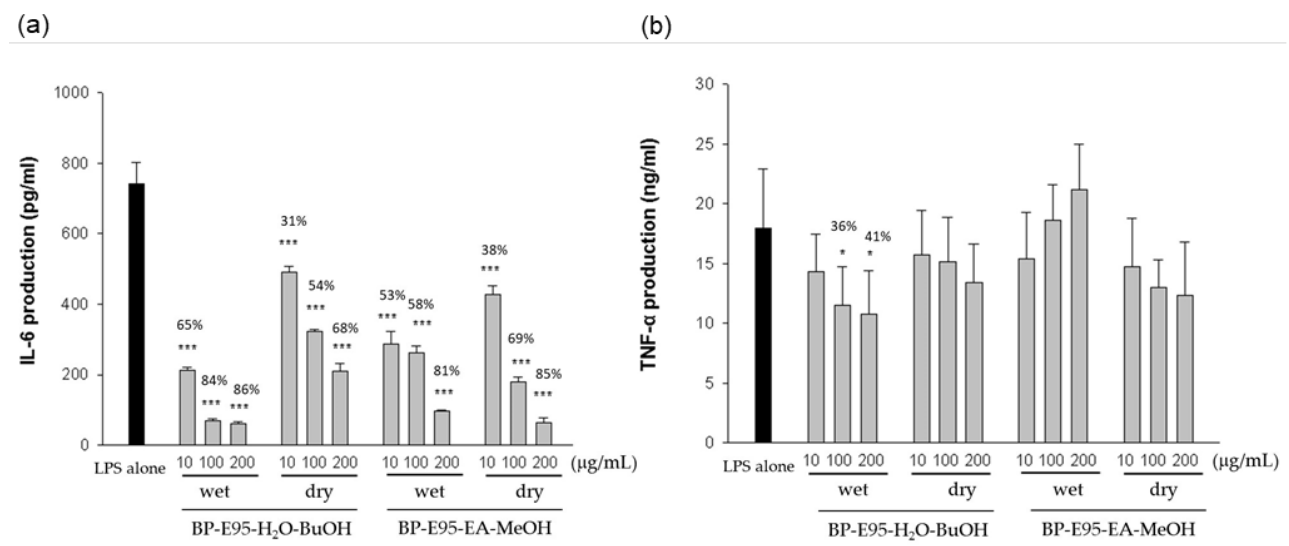
Figure 2. Effects of butanol and methanol subfractions of BP on the release of IL-6 ( a ) and TNF- α ( b ) in LPS-stimulated RAW264.7 cells. Cells were preincubated with or without the indicated BP subfractions for 1 h and then stimulated with LPS (100 ng/mL) for 48 h. Cytokine secretions in culture media were measured by commercial ELISA kits. The levels of IL-6 and TNF- α in untreated control (without LPS) were undetectable. A significant difference from the LPS alone is indicated as * p < 0.05 or *** p < 0.001 according to Student’s t -test. The values in the column represent the inhibition percentage (%) of cytokine secretions by BP extracts. The fresh peel was defined as wet banana peel. The wet banana peel placed in a circulating oven at 60 ◦ C for three days was defined as dry peel. BP, banana peel; E95, 95% ethanol extract; BuOH, butanol subfraction; MeOH, methanol subfraction.